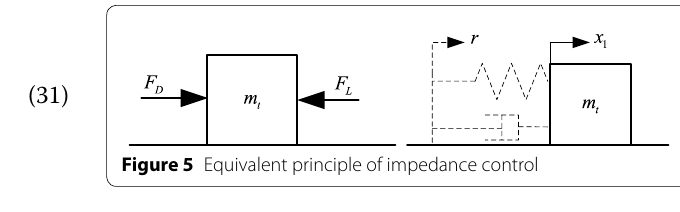
Figure 5 Equivalent principle of impedance